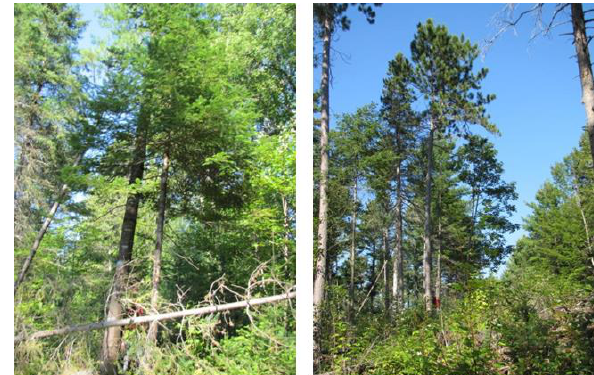
Figure 1. Ground photos showing dense forest (left) and open forest (right) in the study site